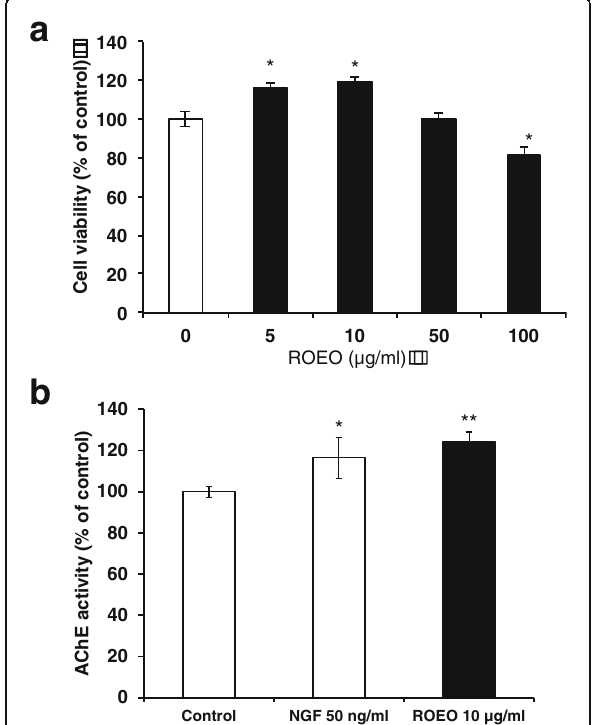
Fig. 2 Effect of Rosmarinus officinalis essential oil (ROEO) on PC12 cell proliferation and acetylcholinesterase activity. a Effect of ROEO on PC12 cells viability. PC12 cells were seeded onto 96-well plates at a density of 1×10 5 cells/ml. After overnight incubation, cells were treated with 0, 5, 10, 50 or 100 μ g/ml ROEO for 48 h and the cell viability was evaluated using MTT assay. Data are presented as a percentage of the control and represent the mean of three independent trials ±.SD * P ≤ 0.05 vs. control. b Effect of ROEO on the acetylcholinesterase (AChE) activity in PC12 cells. PC12 cells were seeded onto 96-well plates at a density of 1×10 5 cells/ml. After overnight incubation, cells were treated with 50 ng/ml of nerve growth factor (NGF) or 10 μ g/ml of ROEO for 48 h. The control indicates cells incubated for 48 h without NGF or ROEO treatment. AChE activity was expressed in percentage of control. Data represent the mean of three independent trials ±.SD * P ≤ 0.05, ** P < ≤ 0.01